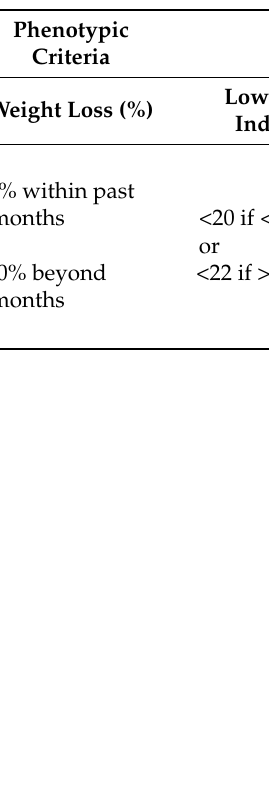
Table 7. GLIM Criteria: Phenotypic and Etiologic Criteria for the Diagnosis of Malnutrition.